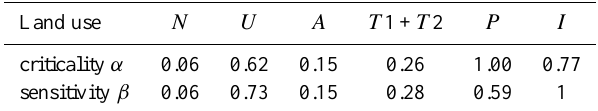
Table 3. Coefficients of criticality α and sensitivity β